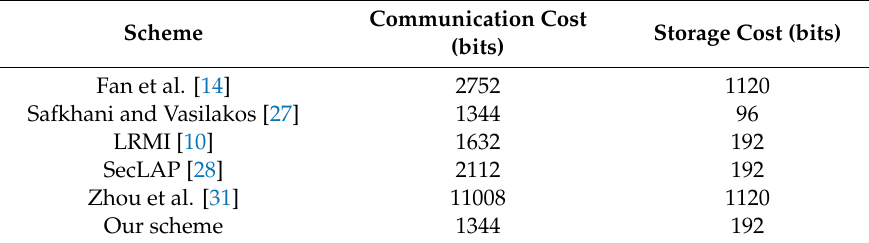
Table 6. Performance comparison based on the communication and storage